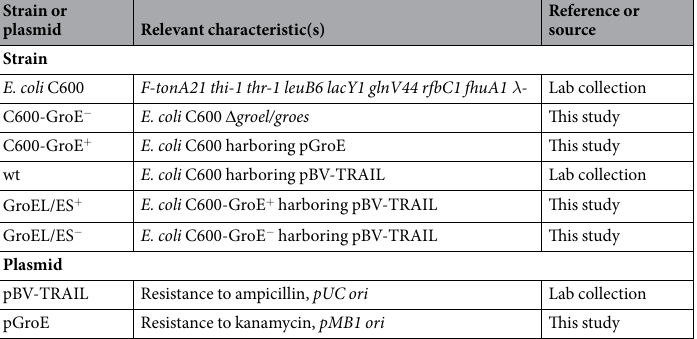
Table 2. List of strains and plasmids used in this study.